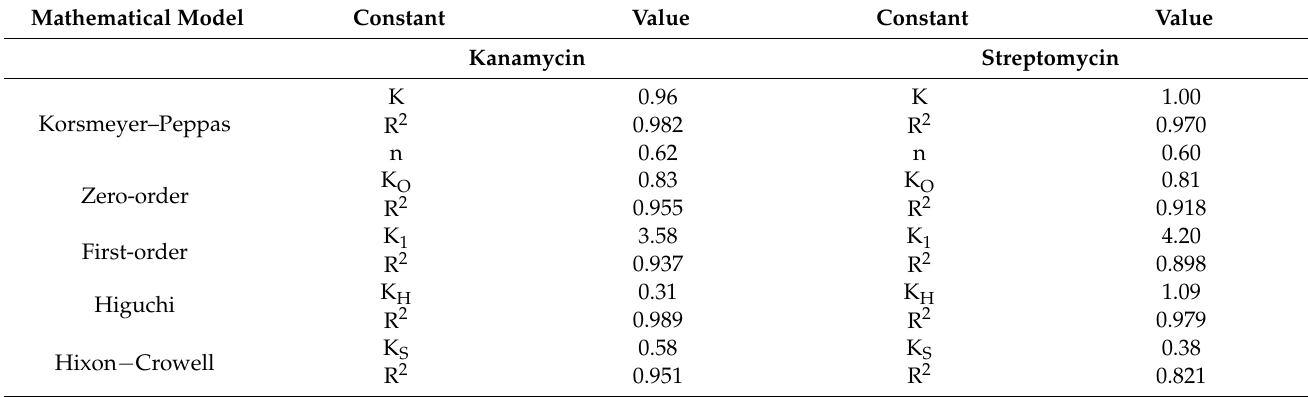
Table 1. Kinetic release variables derived from mathematical models to describe AGA release from the microspheres. Mathematical